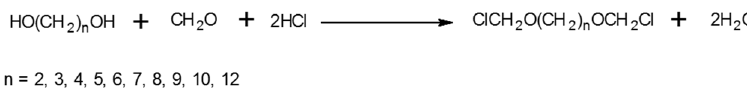
Figure 7. Spacing parameters for the cubic and micellar phase formed in the tested mixtures as a